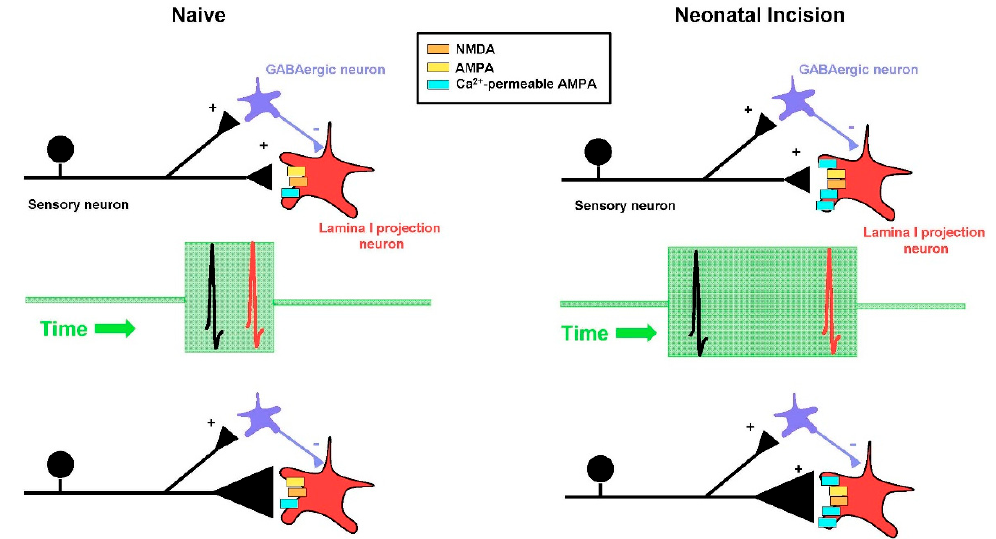
Figure 1. Early tissue damage widens the timing window for evoking spike timing-dependent long-term potentiation (t-LTP) at sensory synapses onto adult spinal projection neurons. Left column (Naïve) : In naïve adult mice, highly correlated presynaptic (black) and postsynaptic (red) action potential firing (i.e., occurring within a window of 10–20 ms; green box) led to a strengthening of primary afferent synapses onto ascending lamina I projection neurons. This reflected an increase in the probability of glutamate release from the presynaptic terminals of the sensory neurons, as illustrated here by a larger size of the presynaptic terminals (black triangles in bottom panels). Right column (Neonatal Incision) : In adult mice subjected to neonatal surgical injury, the timing window for generating t-LTP (green box) at afferent synapses onto spinal projection neurons significantly widened, such that poorly correlated presynaptic and postsynaptic firing (at pairing intervals ≥ 50 ms; middle panel) was still able to generate t-LTP. This enhanced propensity to generate t-LTP likely results, at least in part, from an elevated expression of Ca 2+ -permeable α -amino-3-hydroxy-5-methyl-4-isoxazolepropionic acid (AMPA) receptors (AMPARs) (blue rectangles) in mature projection neurons following early tissue damage, since blocking these glutamate receptors prevented t-LTP in neonatally-injured mice but not naïve littermate controls [69]. NMDA: N -methyl- D